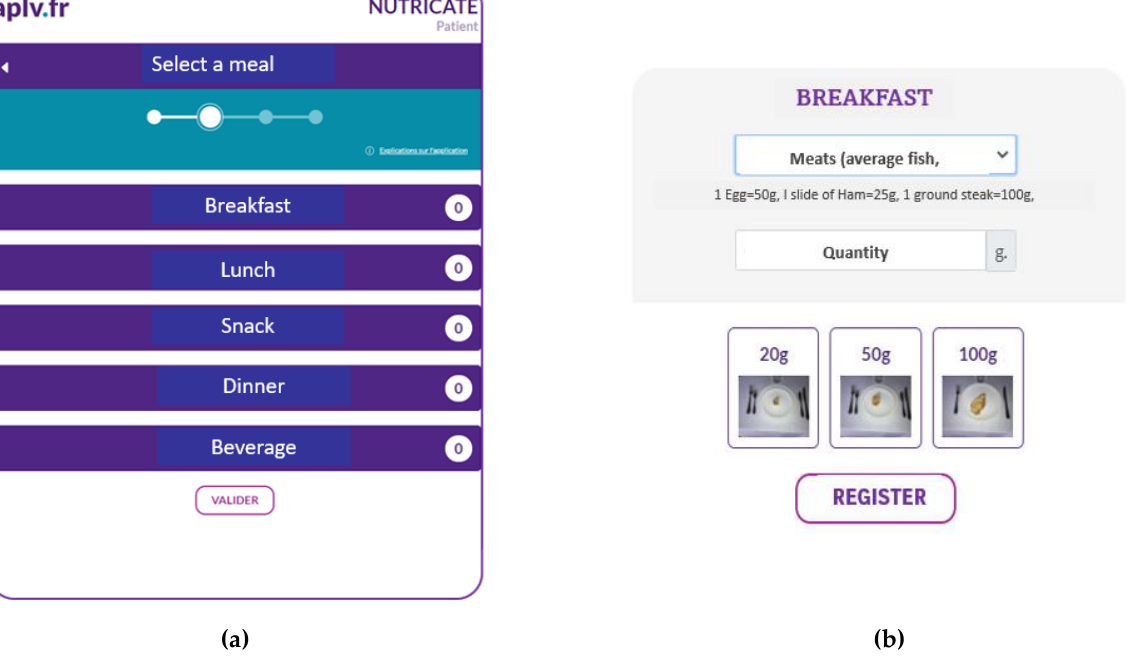
Figure 1. ( a ) Screenshot of the Nutricate© homepage (translated version). ( b ) Screenshot of Nutri- cate© food pictures with increasing portion sizes (translated version). Table 2. Example of a Nutricate© individual dietary report (translated